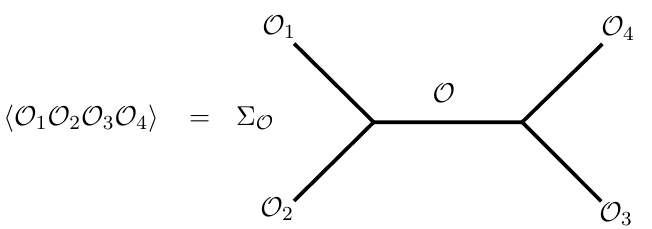
Figure 2. Four-point function factorized into three-point